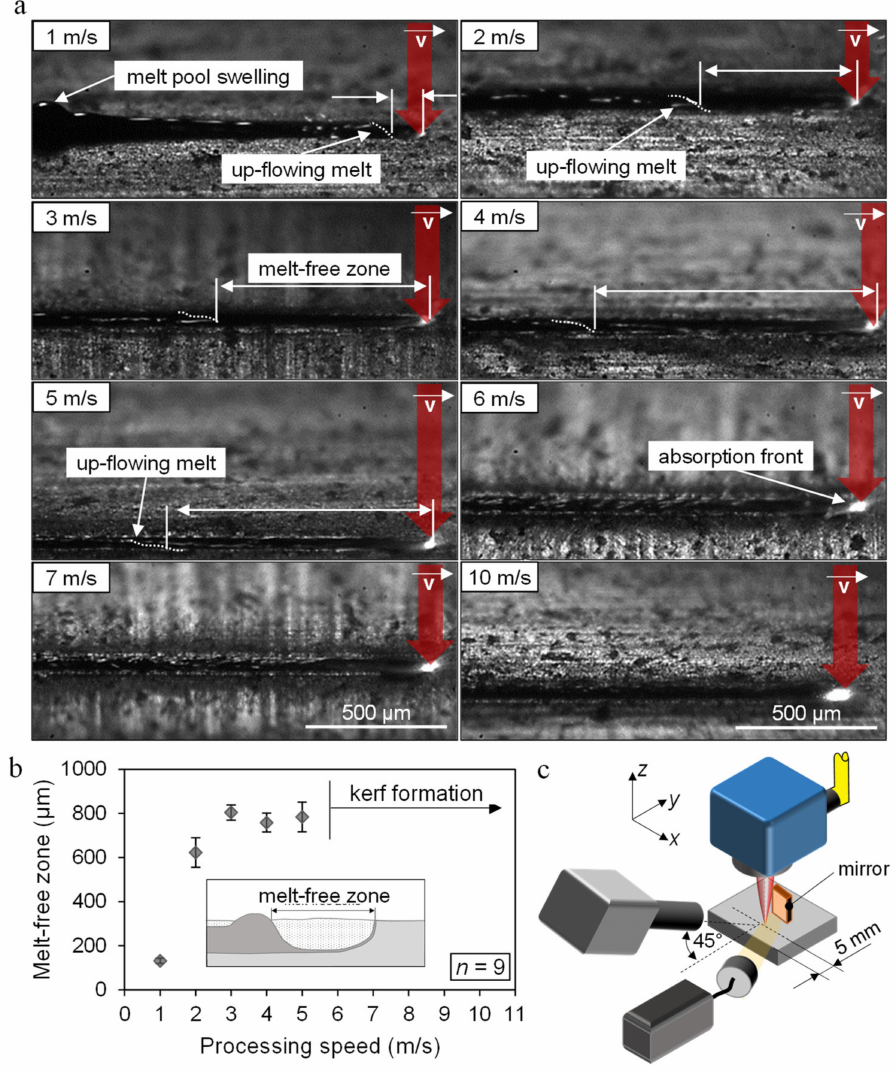
Figure 9. ( a ) Snapshots of high-speed records; ( b ) length of the melt-free zone for different processing speeds; ( c ) camera setup for records from above at an angle of 45 ◦